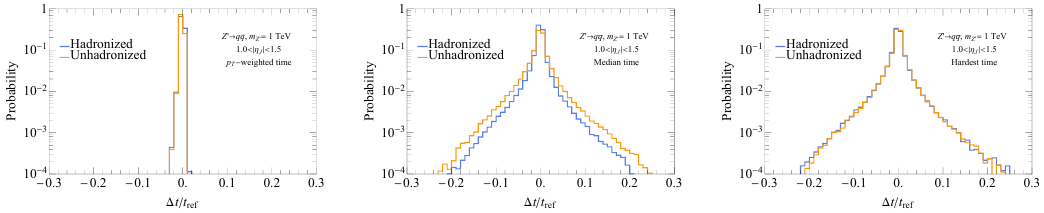
Figure 19 . The relative time difference distributions with and without hadronization for the p T - weighted time (left), median time (center), and hardest time (right) with 1 . 0 < | η